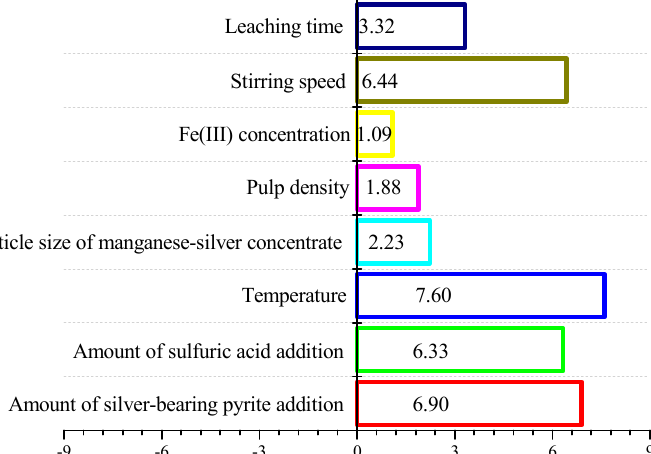
Figure 3. Estimated effects of eight parameters via Plackett–Burman design on Mn leaching